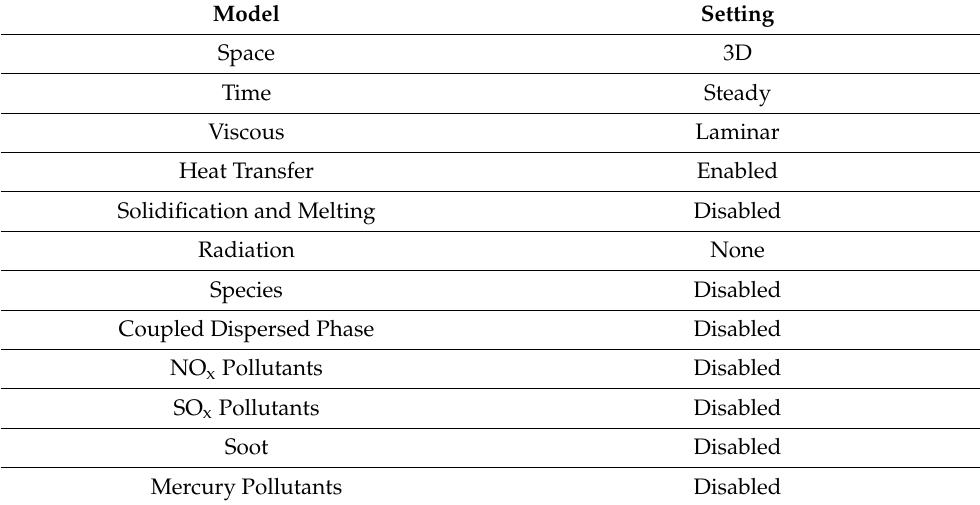
Table 4. FLUENT model